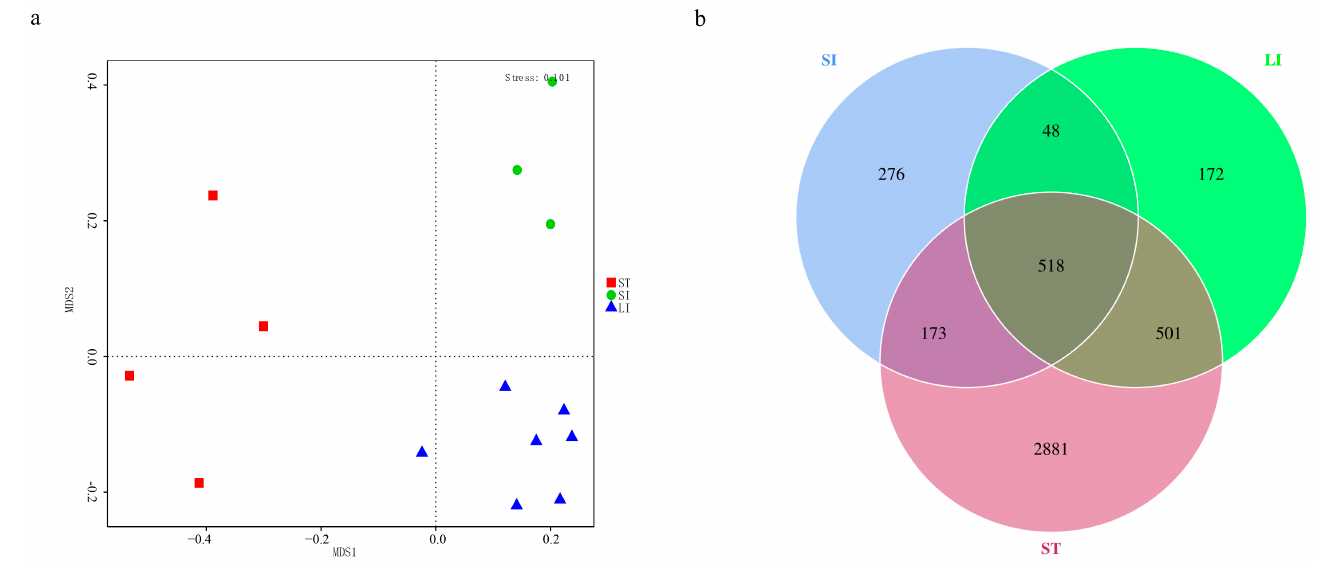
Figure 2. ( a ) Non − metric multidimensional analysis of the microbial community structures of the gut microbiota in the three segments of the L. rufozonatus digestive tract. ( b ) Venn diagram of gut microbiota in Lycodon rufozonatus at the operational taxonomic unit (OTU). Abbreviations: LI, large intestine; SI, small intestine; ST, stomach.